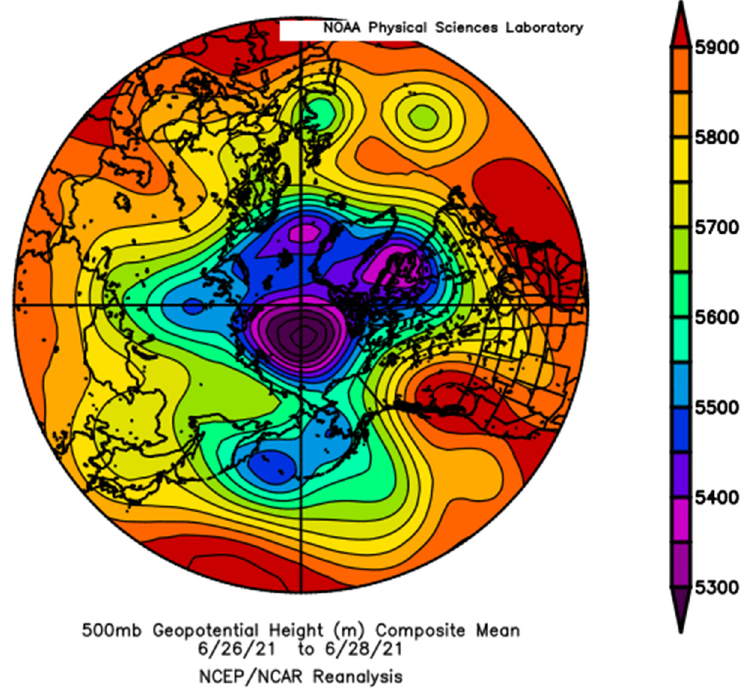
Figure 3. Geopotential height field at polar vortex level (500 hPa) during the main impact on the Pacific Northwest (26–28 June 2021).